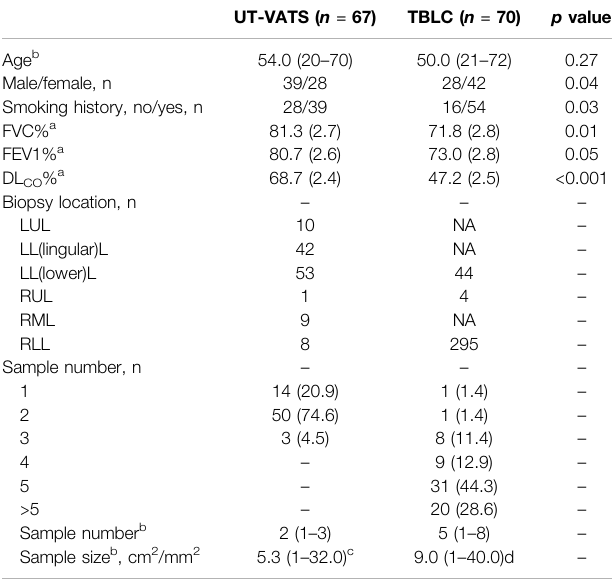
TABLE 1 | Characteristics of patients undergoing UT-VATS or